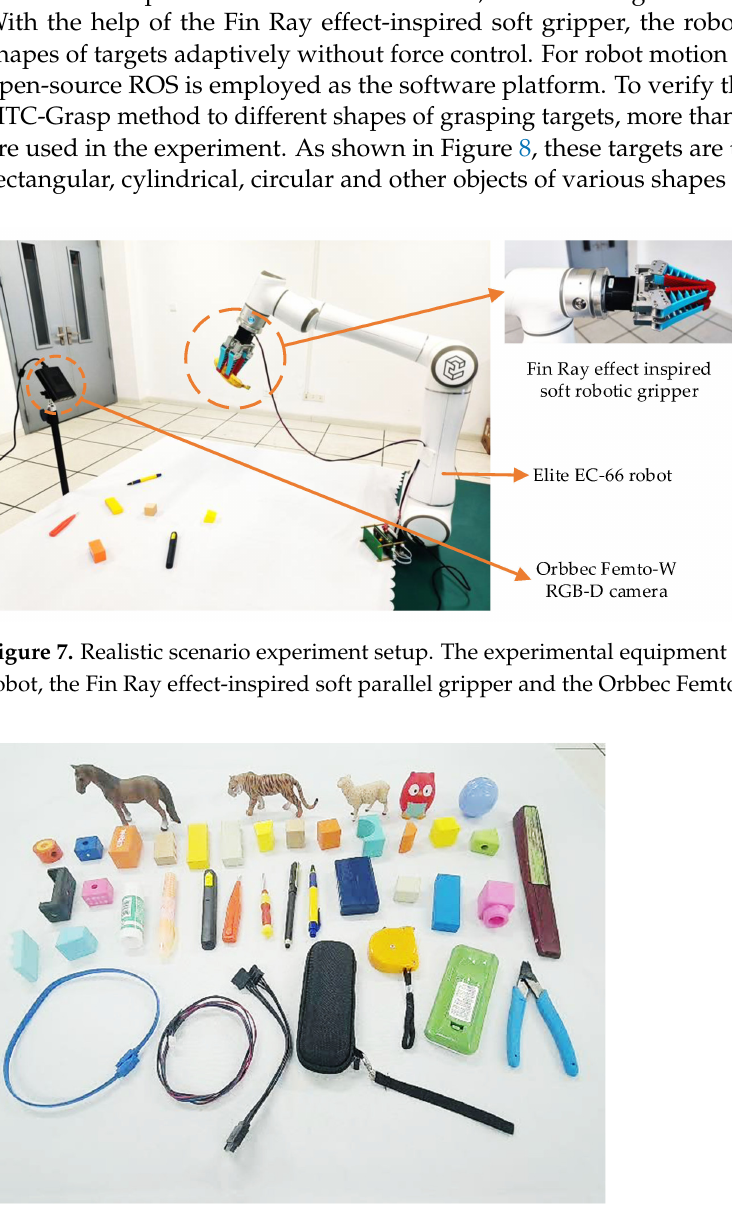
Figure 8. Household objects used in the experiment.